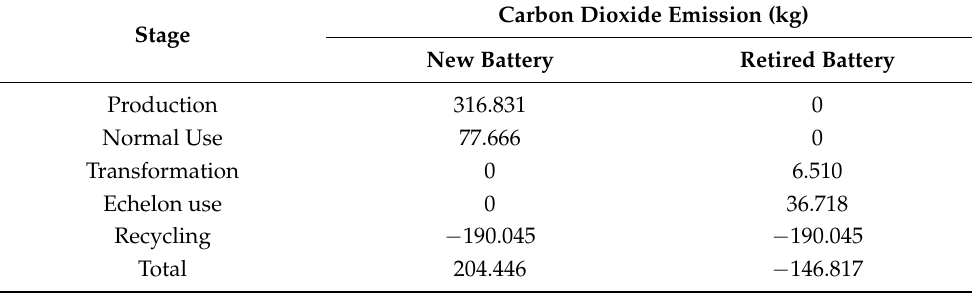
Table 8. Carbon emission of 1 kWh battery in the life